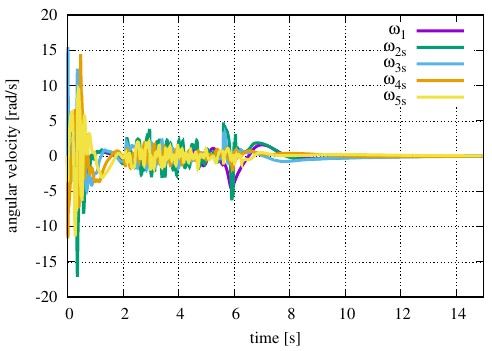
Figure 11. Case 1: Time variation of the angular velocities.